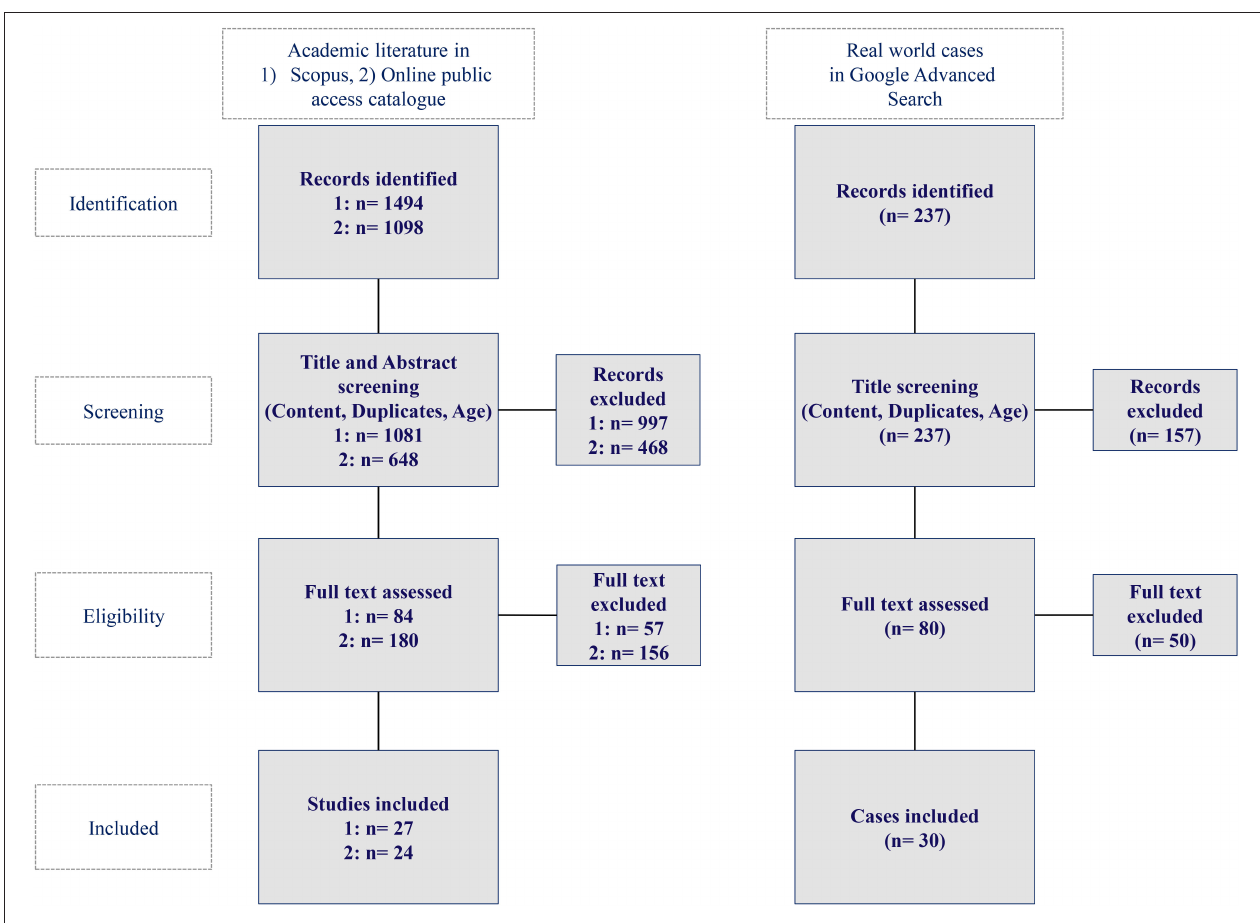
FIGURE 3 | Prisma flow diagram for academic literature and real world case research